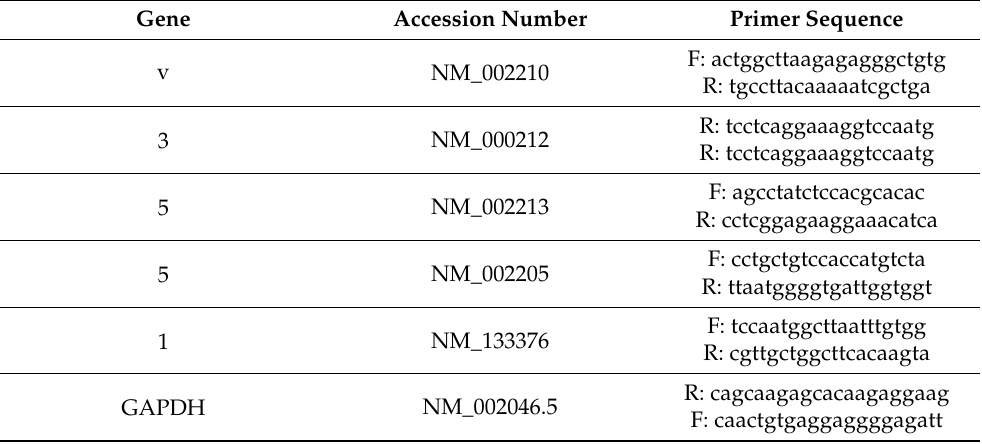
Table 1. Primers used to amplify RGD-binding integrin mRNA in qRT real-time PCR